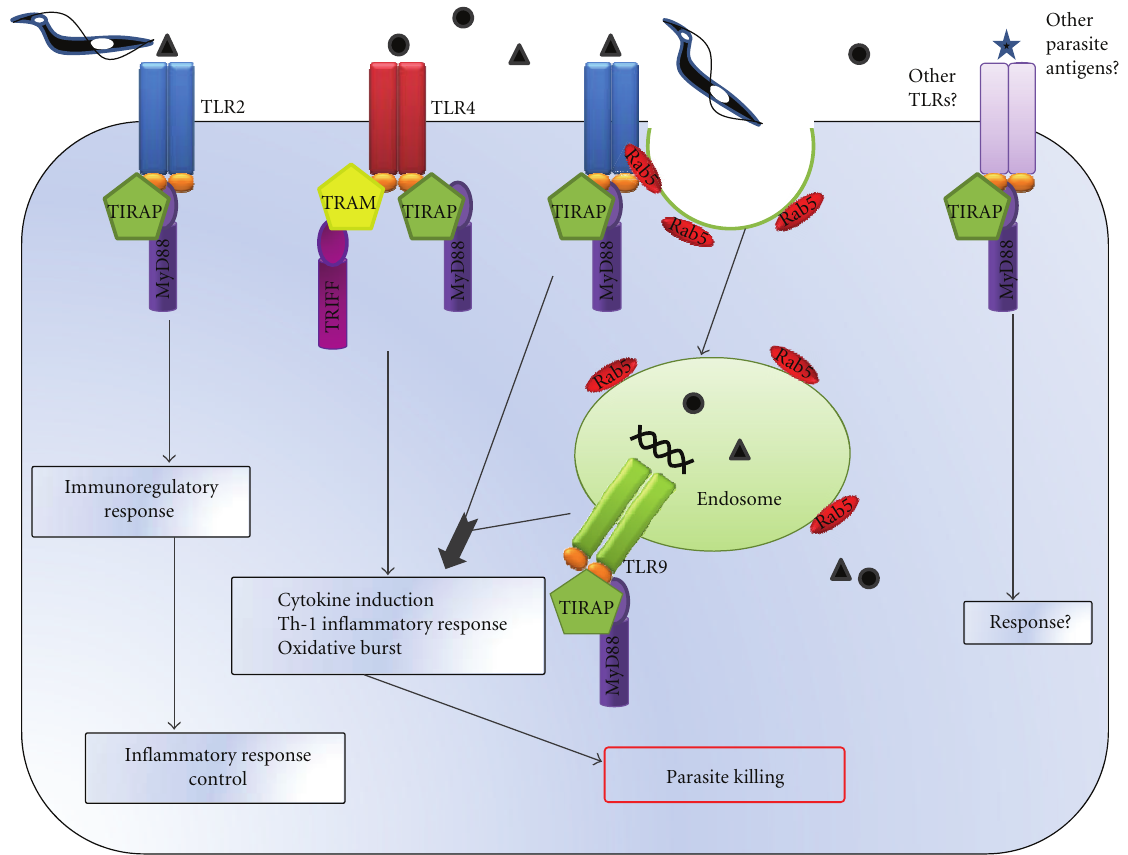
Figure 1: TLR-dependent innate immune responses. T. cruzi -derived components are recognized by TLR2, TLR4, and TLR9, triggering the production of proinflammatory cytokines and microbicidal e ff ectors. Thus, parasite antigens and the cytokines locally released act together to promote the development of protective Th1 response, which lead to parasite growth control. Moreover, TLR2 signaling also has immunoregulatory properties essential to hinder the immune response induced by the parasite. Regarding the T. cruzi entry process, TLR2 but not TLR4 is involved in the activation of Rab-5, fusion of early endosomes, and phagocytosis of trypomastigotes. Furthermore, it is plausible to think that others unexplored TLRs and/or parasite antigens could be involved in the induction of the innate immune responses against T.